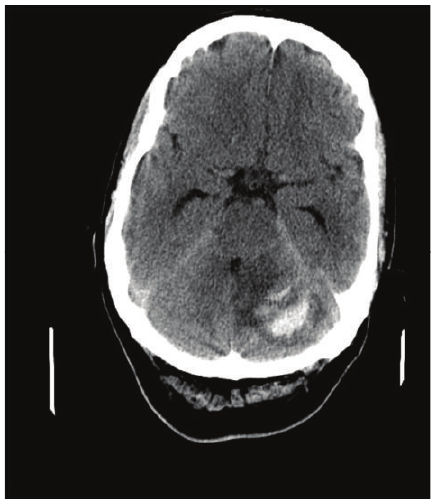
Figure 2: Cranial BT image showing bleeding at the site of left cere- bellar hemisphere with streaky pattern (zebra sign).